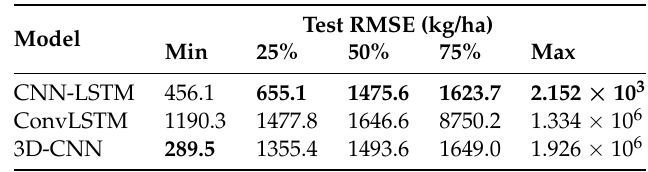
Table 5. The RMSE percentiles accross all trained spatio-temporal models. The RMSE percentiles indicate the consistency of a model architecture in generalizing to unseen samples with the training data. Out of the three, the CNN-LSTM was most consistent in how it was able to fit to the data and produce generalizable results. The training of other model architectures produced occasionally ill-fitted models. Best performance values are in bold